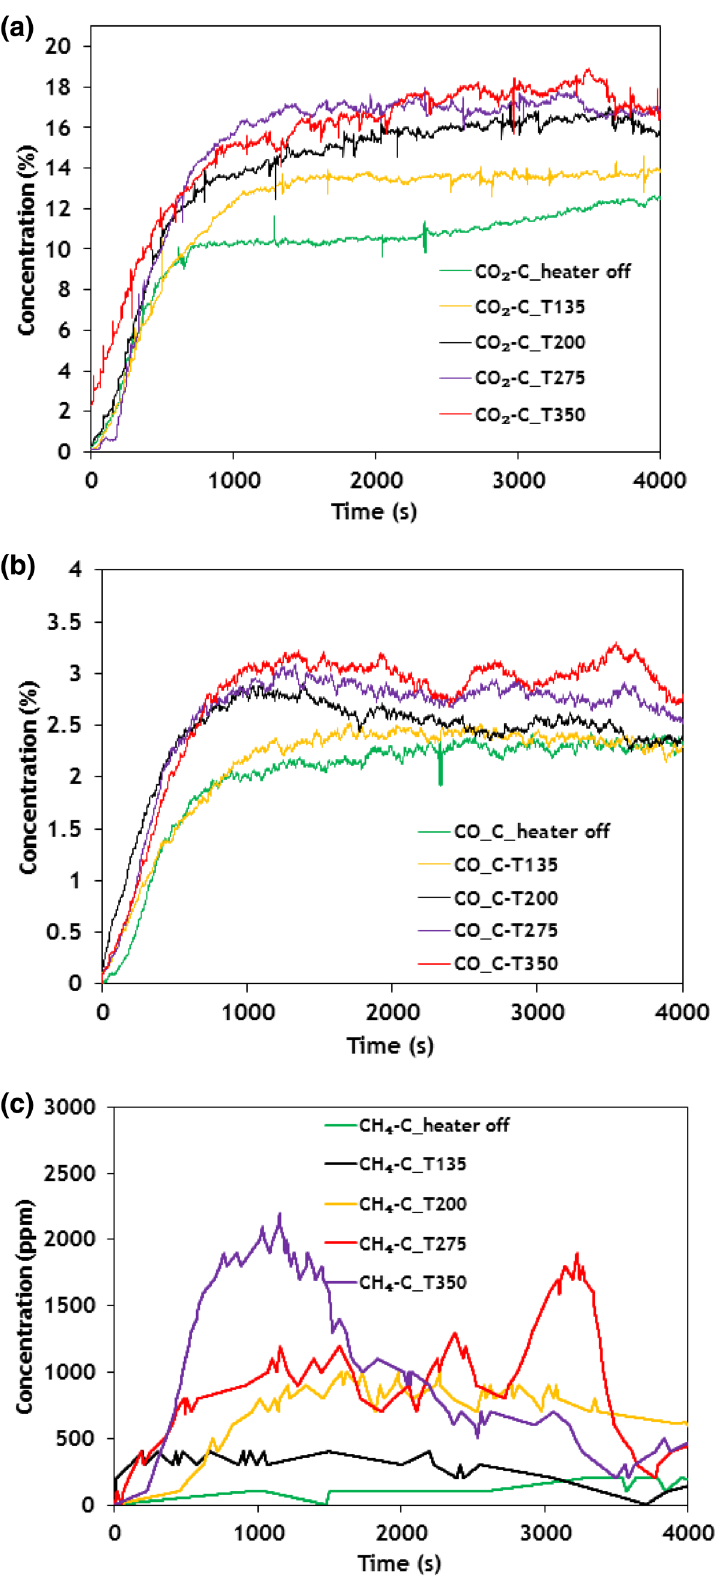
Fig. 14 Gas products of coal C in various temperature a CO 2 , b CO and c CH